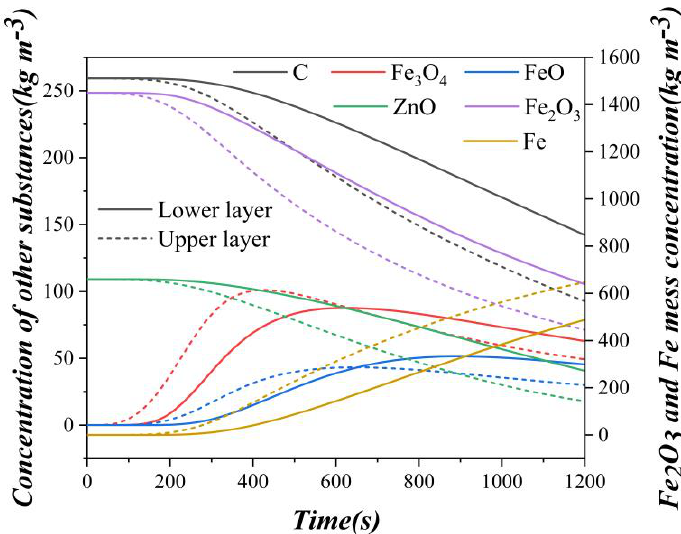
Figure 10. Average mass concentration variations of the upper and lower pellets with time.